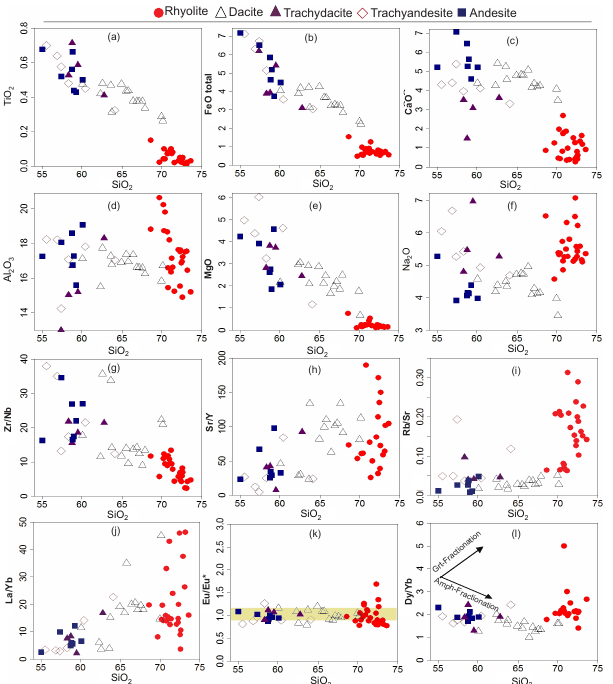
Fig. 6 Figure 6. Harker diagrams of the major oxides (wt%) and incom- patible element ratios vs. SiO 2 for the studied rocks.